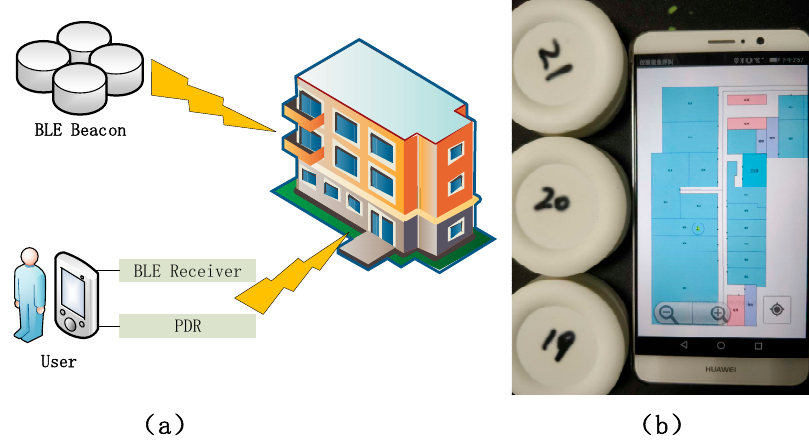
Figure 1. ( a ) The architecture of the Bluetooth Low Energy (BLE) indoor positioning system; ( b ) the BLE beacons and the smartphone used in this paper.